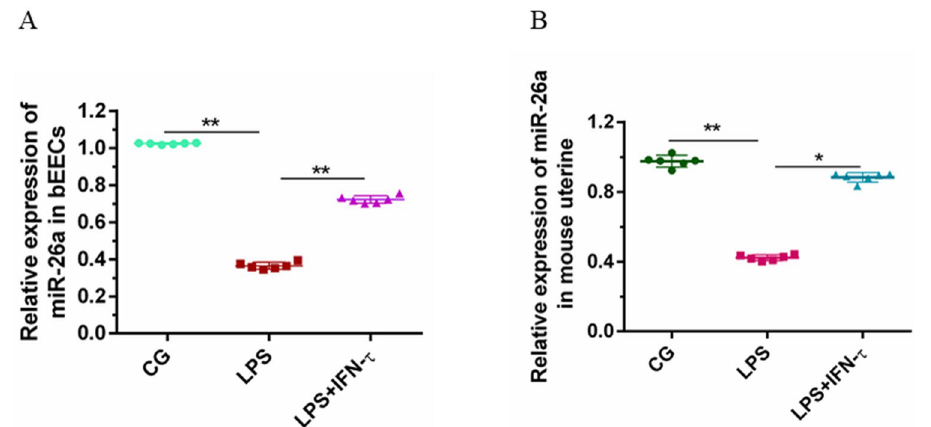
Figure 3. IFN-τ mediates miR-26a expression. ( A ) The expression of miR-26a in bEECs. ( B ) The total expression of miR-26a in mouse endometrial tissue. CG is the control group, LPS is the model group, and IFN-τ + LPS is the experimental group. Data are expressed as mean ± S.D., three independent experiments. * p < 0.05; ** p <